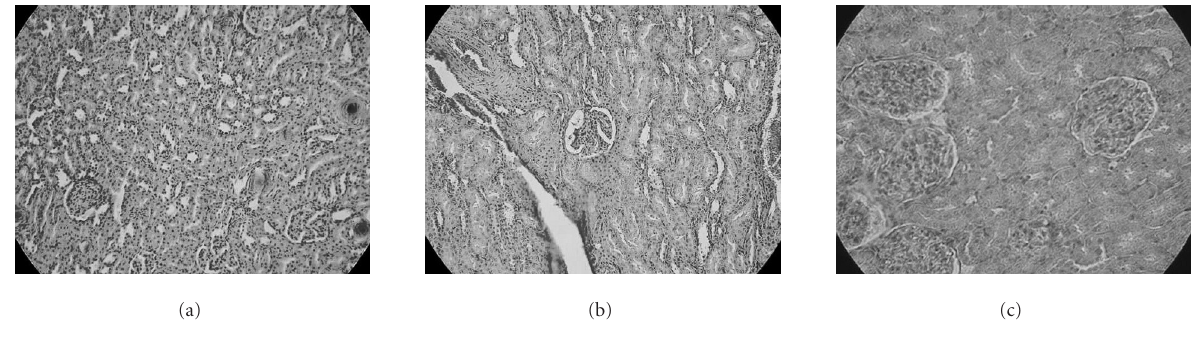
Figure 1. Histological study of the renal cortex. (a) Sham group (200 × ), normal morphology; (b) positive control group (200 × ), glomerular collapse, cortical hemorrhages, vascular congestion, dilatation of convoluted tubules and glomerular capsule dilatation; and (c) ozone group (400 × ), a discrete dilatation of convoluted tubules.